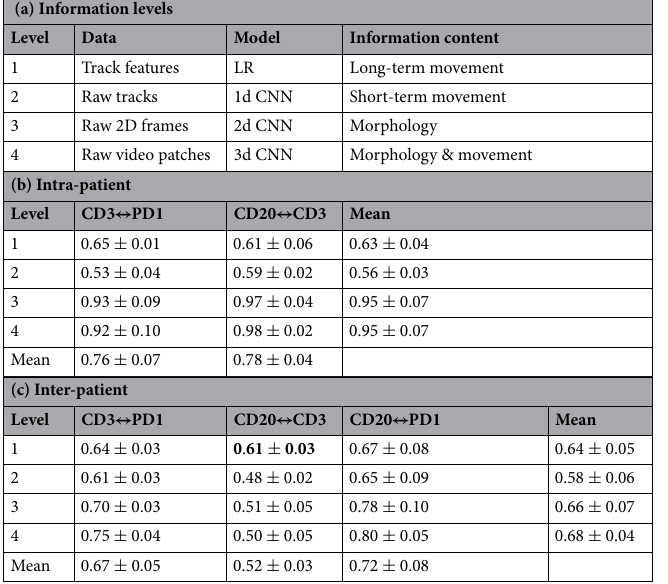
Table 1. The impact of temporal information on the classification of phenotypes. Table (a) Information levels arising from different data representations that are used for training different models. Tables (b and c) show crossvalidation results reported as mean and standard deviation of the AUC out of 5 runs per fold, where for Table (b) results on 4 (CD3 PD1) and 5 (CD20 CD3) movies (leave-one-movie-out) and for Table (c) results on 24 movies with 3 folds (with no patient overlap) were